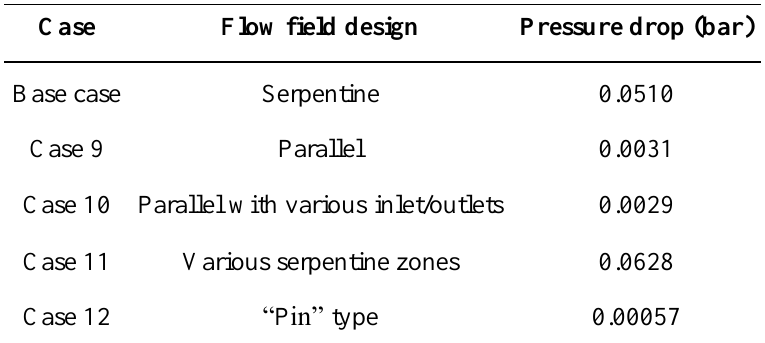
Table 3. Pressure Drop for different flow field